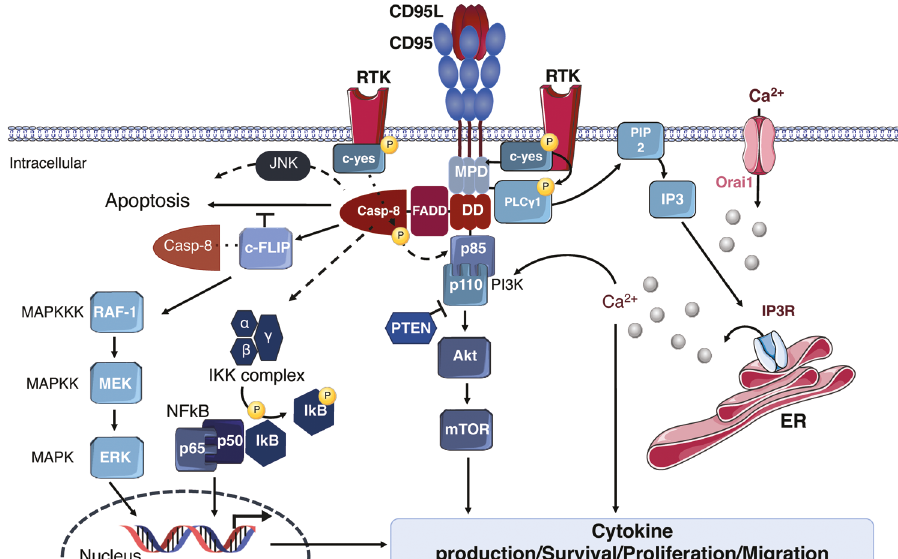
Fig. 3 CD95-dependent non-apoptotic signaling. Representation of the CD95-mediated unconventional or non-apoptotic pathways. The interaction between CD95 and its ligand CD95L recruits several adaptor proteins leading to the activation of the MAPK, NF- κ B and PI3K pathways. The MAPK pathway requires a cascade of phosphorylations to eventually activate ERK, allowing its translocation to the nucleus where it induces the transcription of pro-survival/proliferation/pro-in fl ammatory genes. The NF- κ B heterodimer is kept inactive by I κ B, which after IKK-mediated phosphorylation releases NF- κ B allowing its translocation to the nucleus where it promotes the transcription of pro- in fl ammtory/proliferation/migration genes. The PI3K/Akt and PLCy1 pathways are functionally linked in triggering the cell migration. Active PLCy1 participates in the elevation of cytoplasmic calcium levels, which then leads the activation of biochemical pathways that leads to cell proliferation, survival and migration through the phosphorylation and activation of